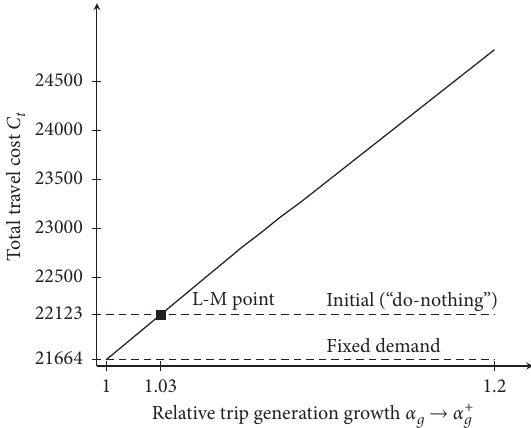
Figure 7: Travel costs C t against trip generation growth.